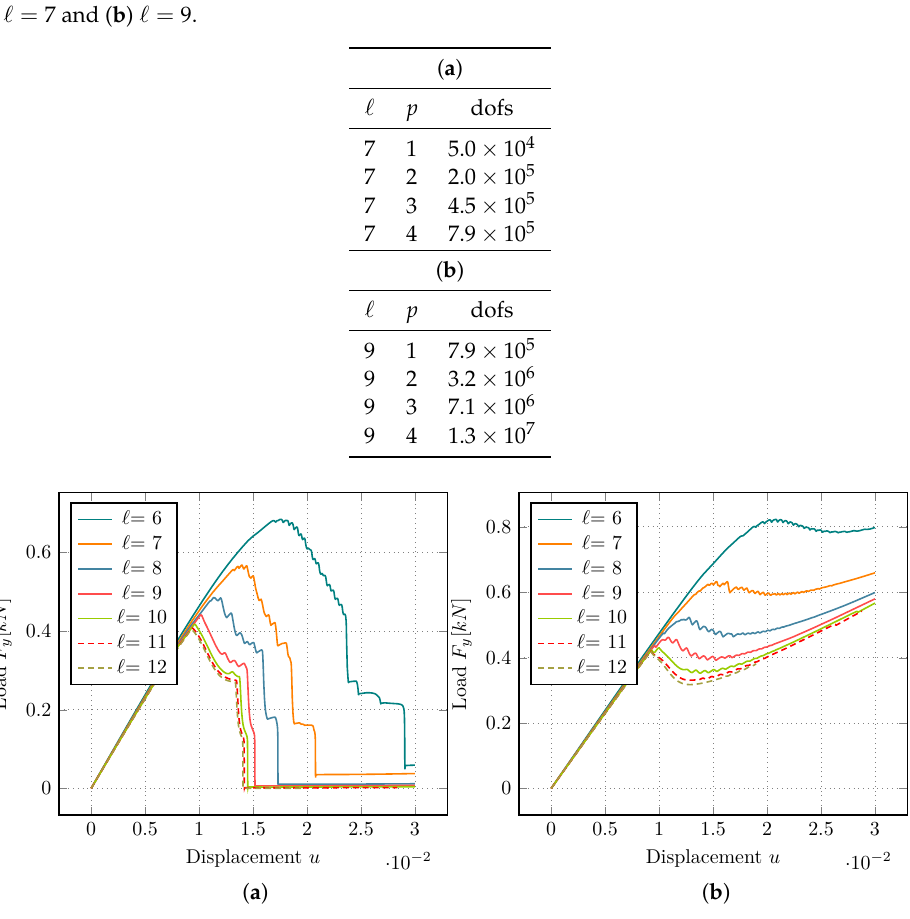
Table 4. Dof counts for varying p for the single-edge notched shear/tension tests. ( a ) Mesh-refinement level (cid:96) = 7 and ( b ) (cid:96) = 9.